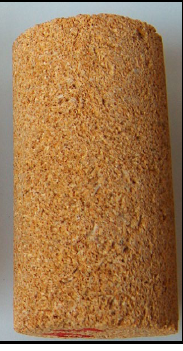
Figure 2. Triaxial test natural sample (D = 38 mm, H = 76 mm).